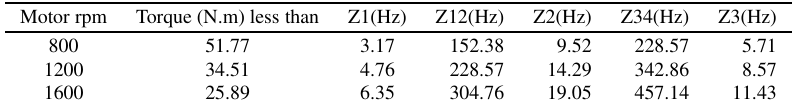
Table 6 The selected nodes, momentum term and learning rate of WNN